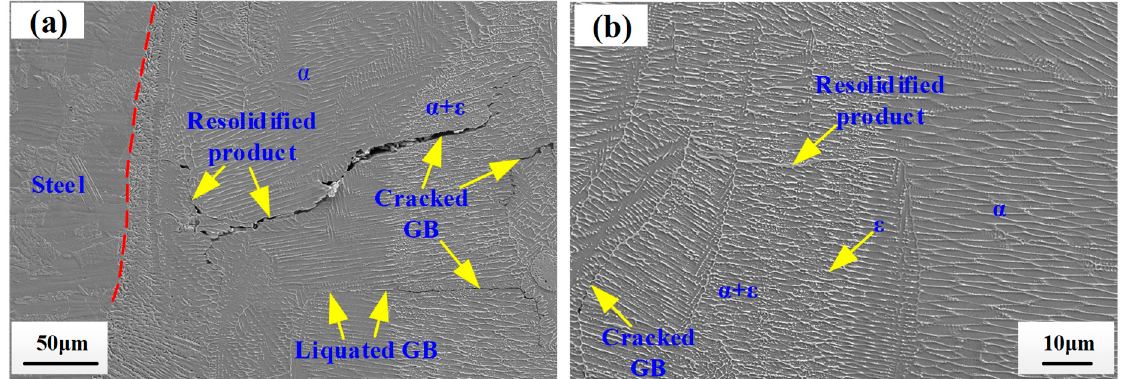
Figure 2. The microstructure of steel/copper laser-welded joint: ( a ) cracking along the grain bound- ary; ( b ) microcracks in the weld metal.